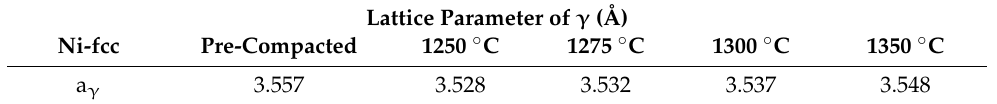
Table 3. Lattice parameter (a) of γ fcc (face centered cubic) crystal structure in the different conditions. Lattice Parameter of γ (Å)